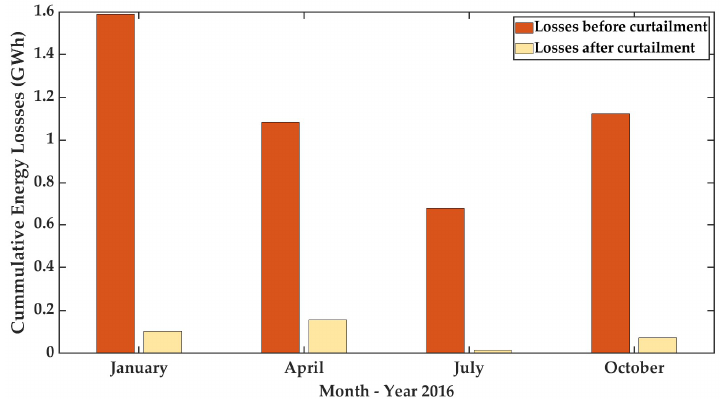
Figure 14. Energy losses per season before and after curtailment.